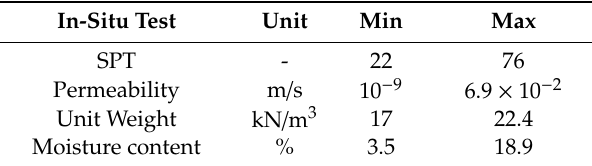
Table 1. Geotechnical field testing results for Phase I of KUR.